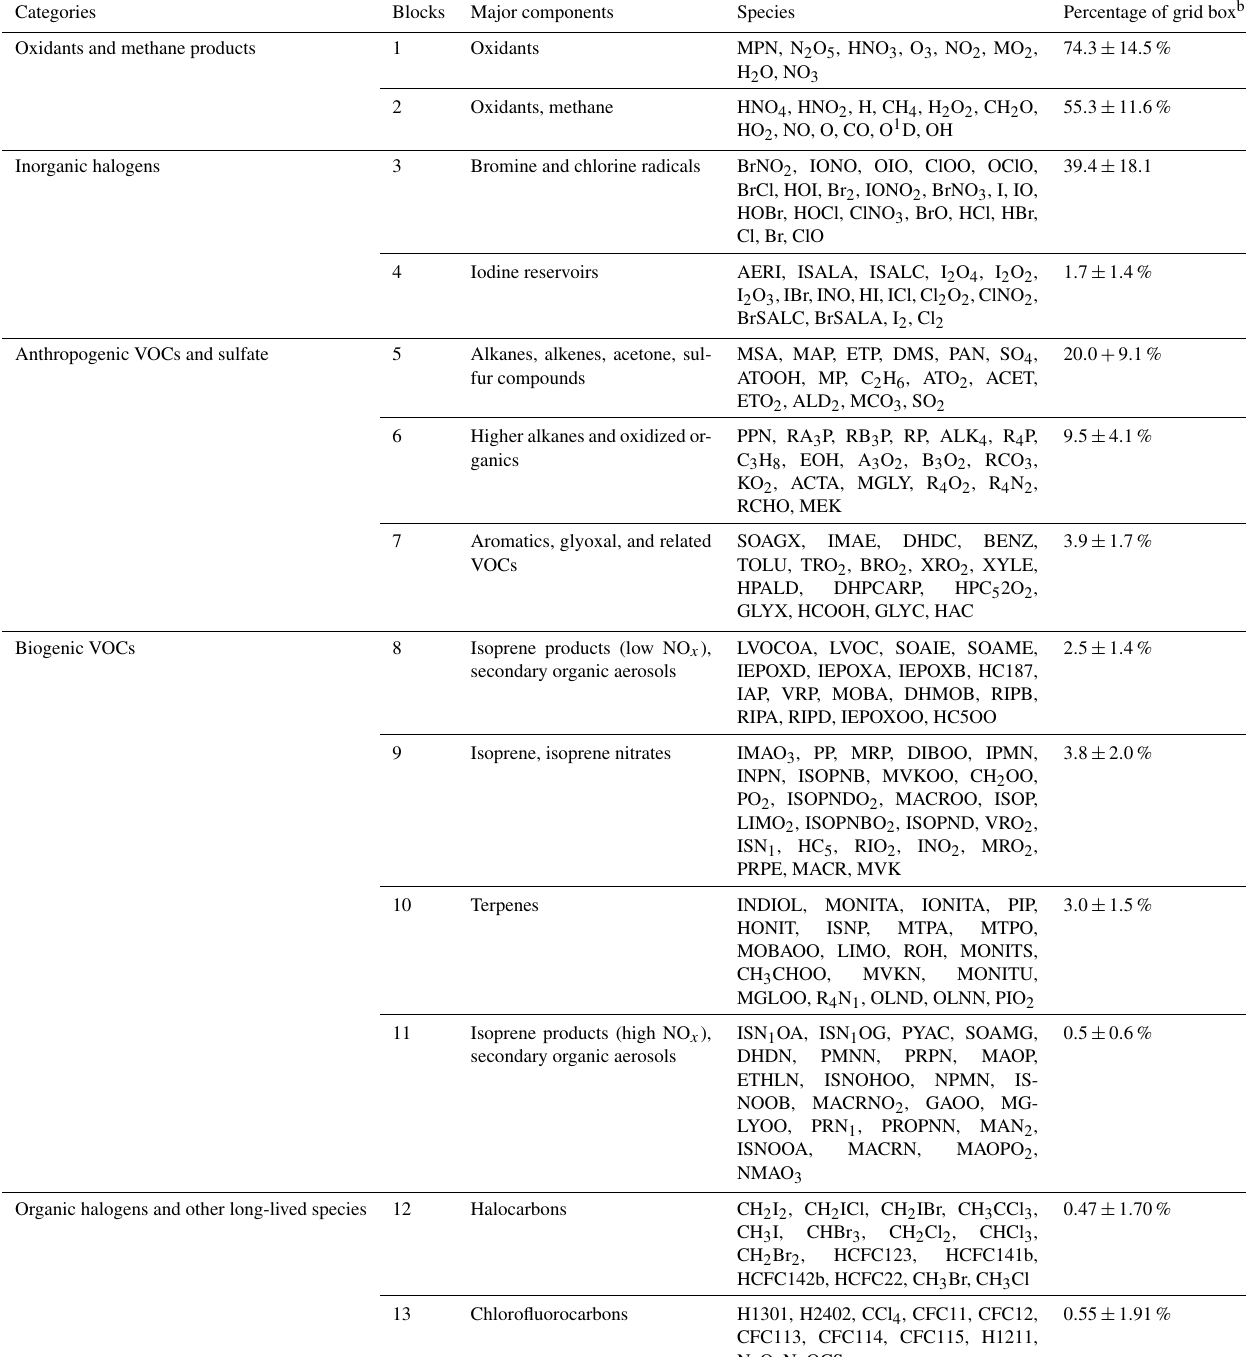
Table 1. Partitioning of GEOS-Chem chemical species into N = 13 blocks a